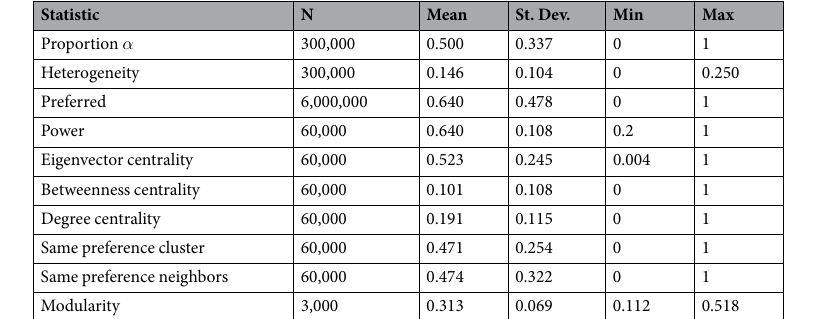
Table 4. Descriptives of the dependent and independent